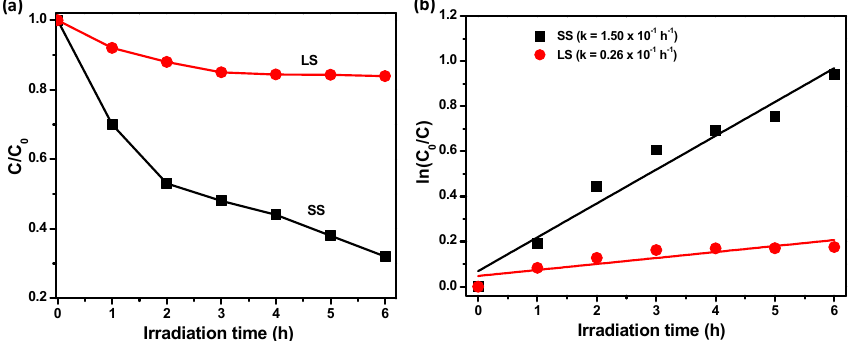
Figure 9. ( a ) Photocatalytic degradation of aqueous solutions of methyl orange dye in the presence of SS and LS SnO 2 under UV–Vis light; ( b ) estimation of the pseudo-first order rate constants of the samples for the dye degradation; the rate constants for the degradation of the dye by the respective photocatalysts are embedded in the figure.